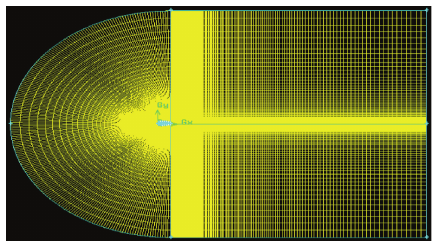
Figure 1: 2D mesh of the entire domain using a map scheme with around 50,000 quadrilateral elements.